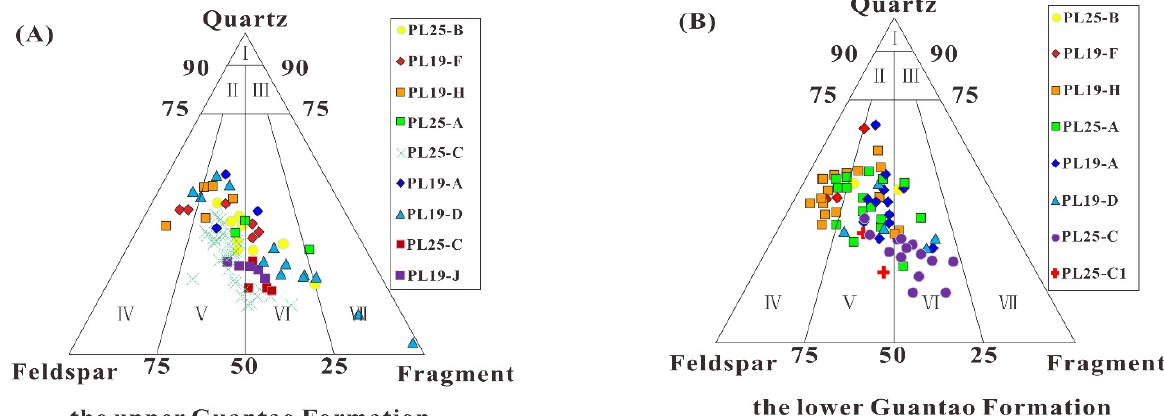
Figure 4. Sandstone composition triangle. ( A ) The triangle chart of sandstone classification in the upper Guantao Formation. ( B ) The triangle chart of sandstone classification in the lower Guantao